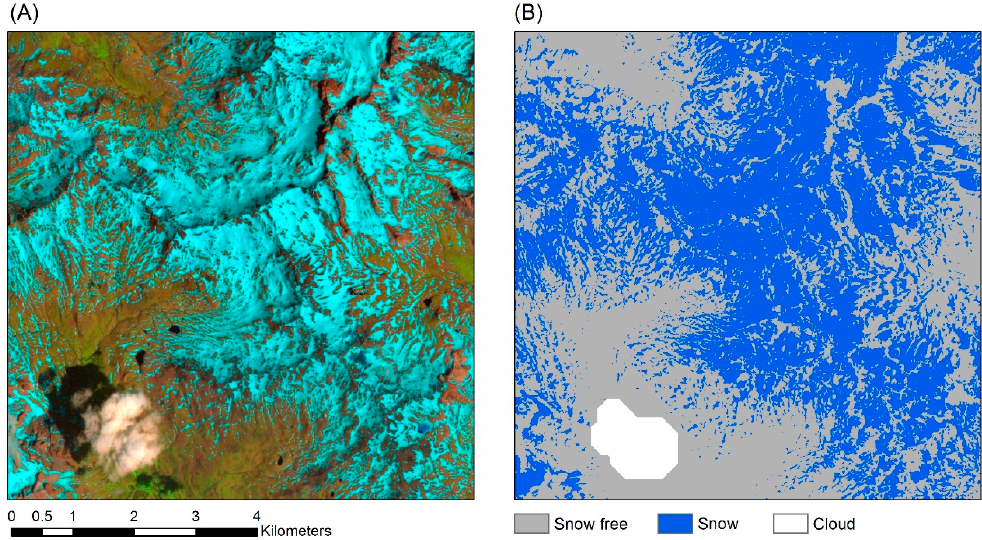
Figure 5. Example snow cover map based on the Normalized Difference Snow Index (NDSI) for a 56 km 2 in the Massif des Cerces (location provided in Figure 1), for 5 June 2015. ( A ) Visible and infrared color composite retrieved from a SPOT-5 image at 10 m resolution, showing snow cover in light blue; and ( B ) map of snow cover showing snow ( blue ), snow free areas ( grey ) and cloud/shadow cover ( white ) derived from a SPOT-5 image © CNES-Cesbio.